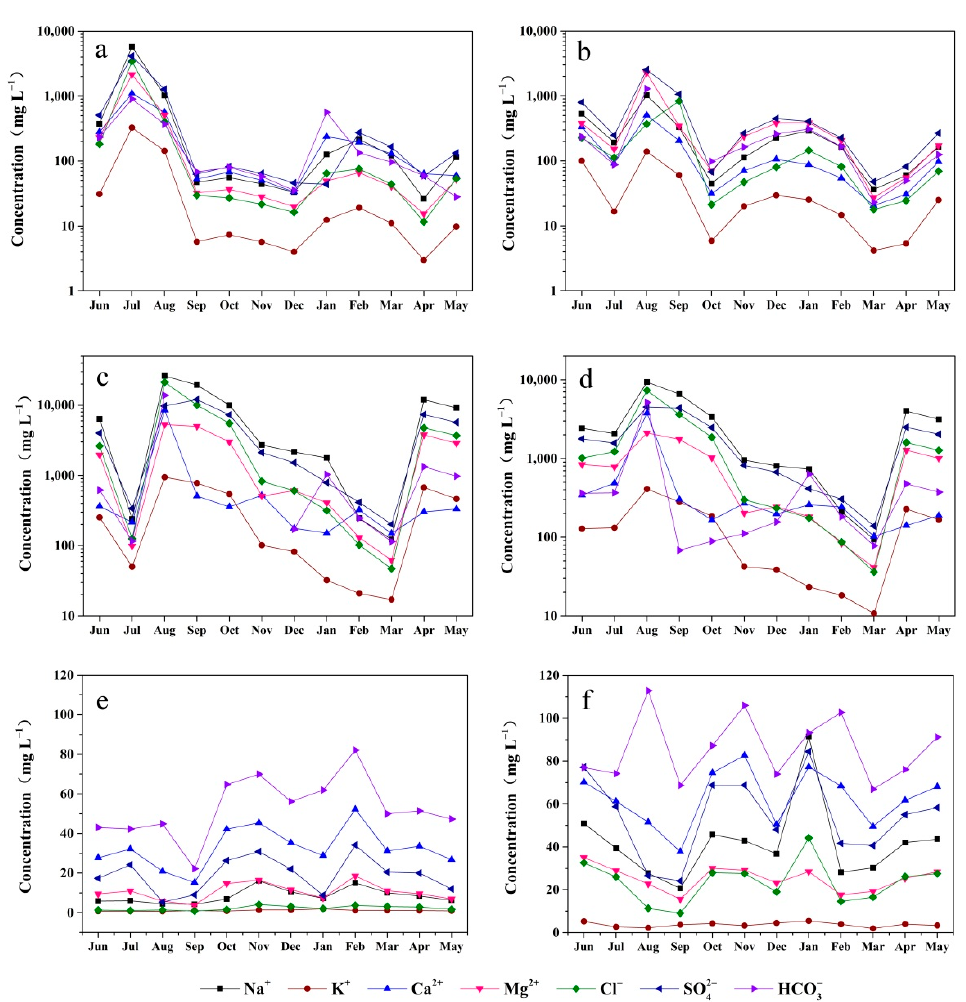
Figure 3. Monthly variation of ions composition in stable catchment A ( a ), stable catchment B ( b ), unstable catchment ( c ), total of Qingtu Lake ( d ), and upper ( e ) and middle ( f ) reaches of the Shiyang River Basin.